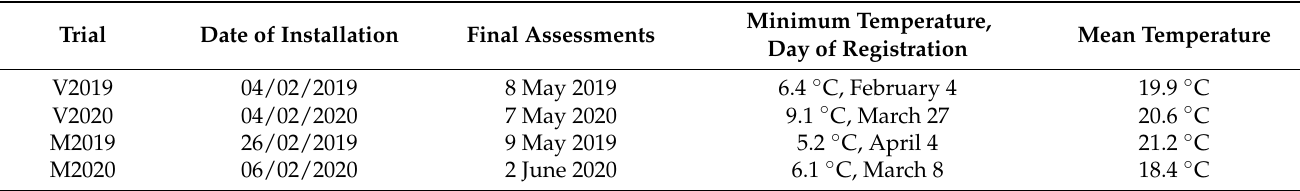
Table 1. Dates of installation and of final assessment of the four greenhouse trials, minimum temperature and day of its registration, and mean temperature during the